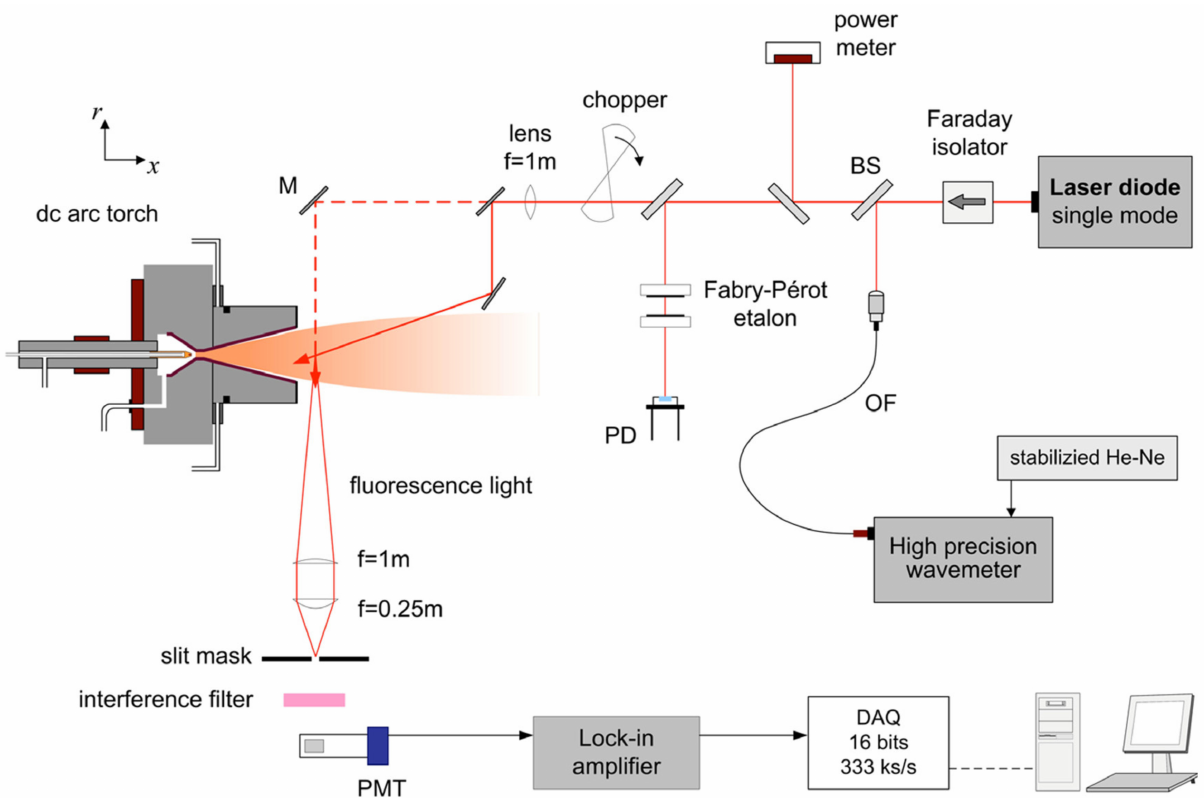
Figure 6. Experimental arrangement for CO 2 expansion flows (from [12]). 4. Venus